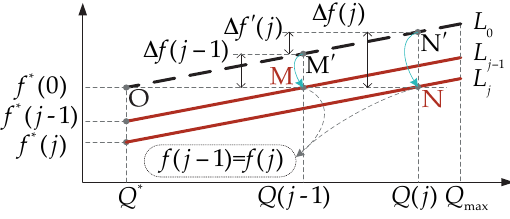
Figure 2. CFR-based frequency droop features of DG.